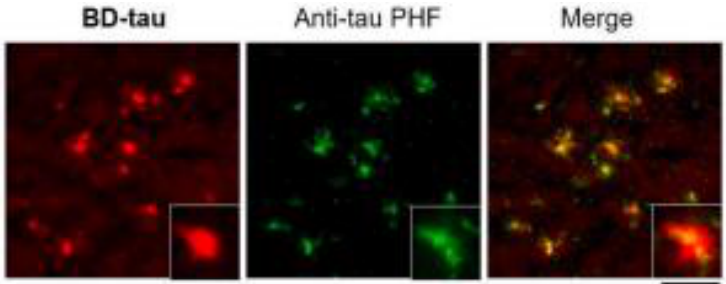
Figure 11. Ex vivo brain slices of tau transgenic mice labeled with the BD-tau and anti-tau paired helical filament (PHF) antibodies to demonstrate the accuracy of tau aggregates detection using BD-tau [105]. The third image is the overlay of the first two. Images are reprinted with permission of the publisher [105].